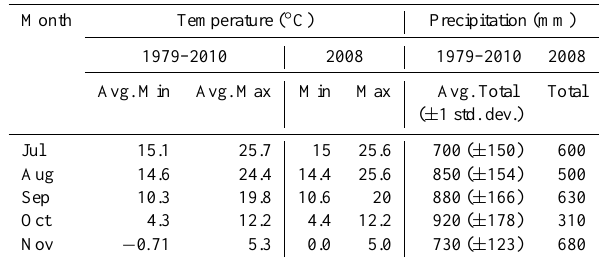
Table 2. UMBS 1979–2010 climatological data for months when measurements were